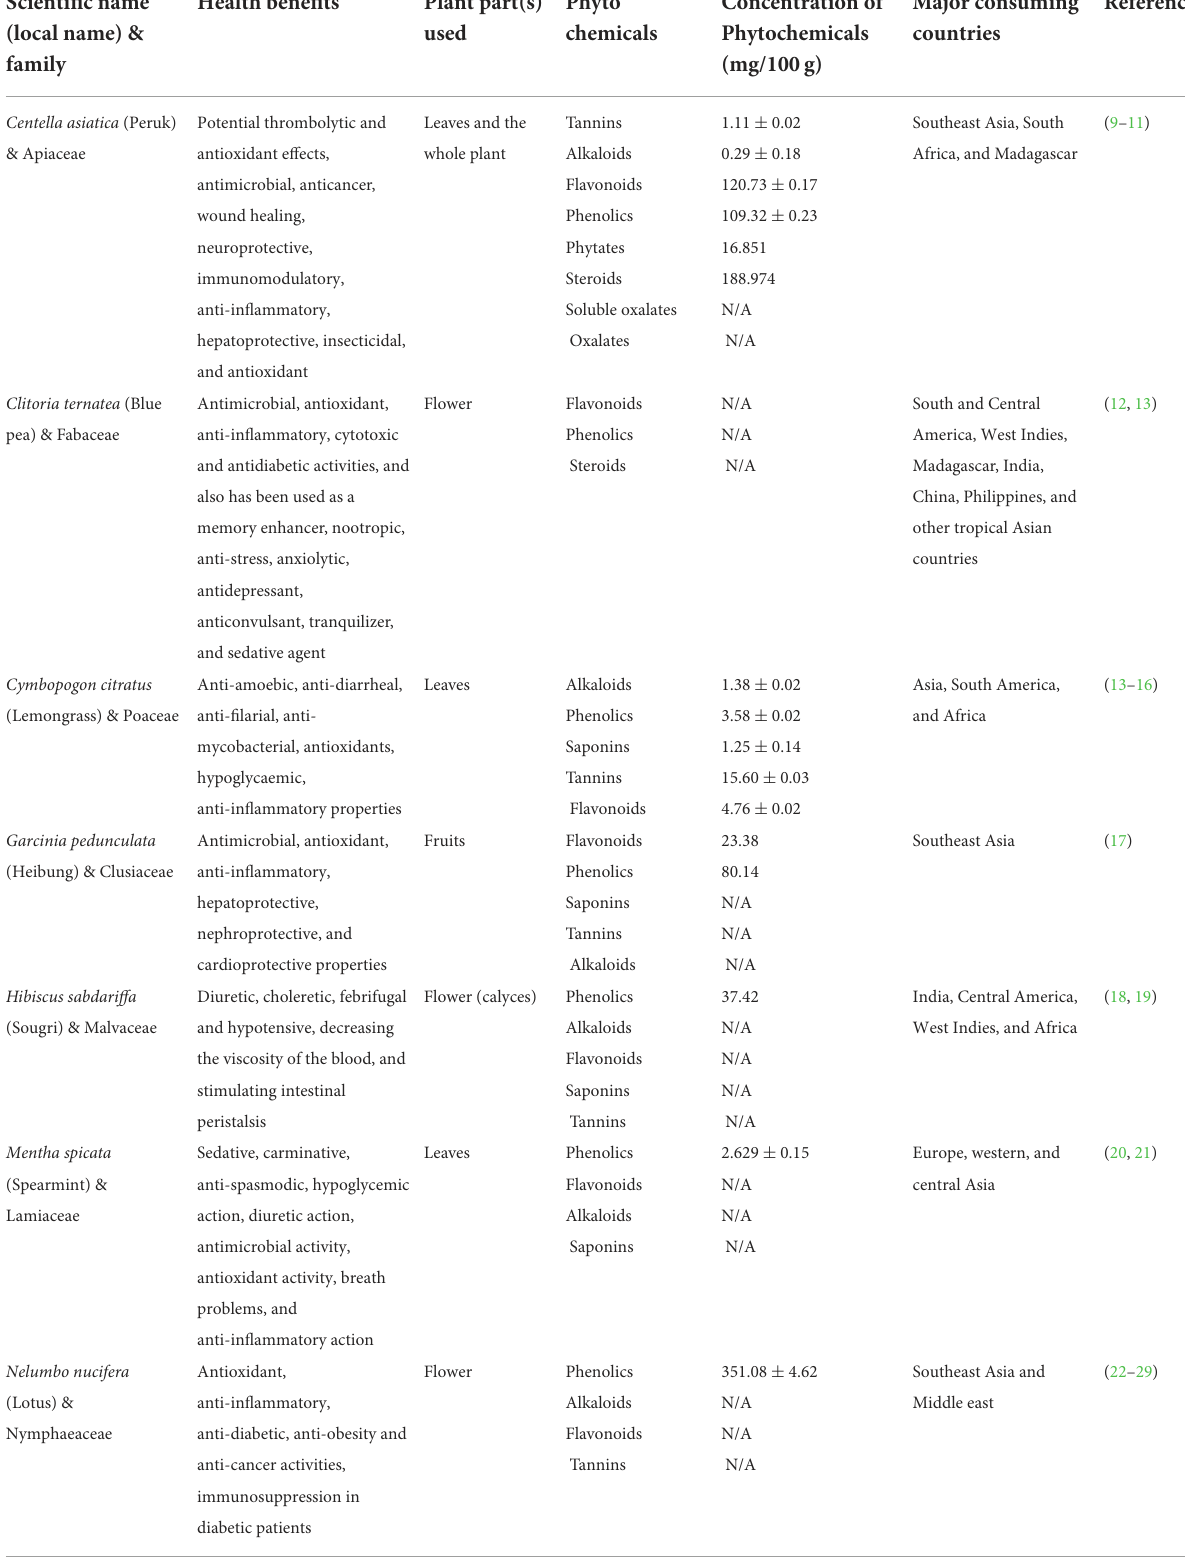
TABLE 1 List of herbal teas studied along with their important phytochemical constituents and health benefits as well as its major consuming